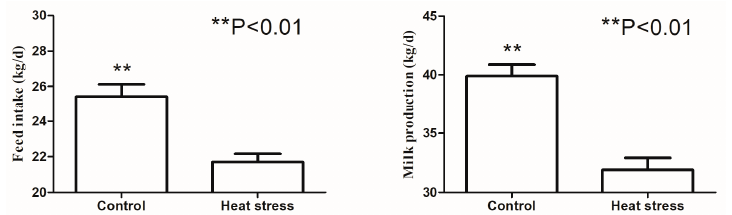
Figure 1. The e ff ects of heat stress on feed intake and milk production in dairy cows. Figure 1. The effects of heat stress on feed intake and milk production in dairy cows. Table 1. The e ff ects of heat stress on rumen fermentation. Table 1. The effects of heat stress on rumen fermentation.